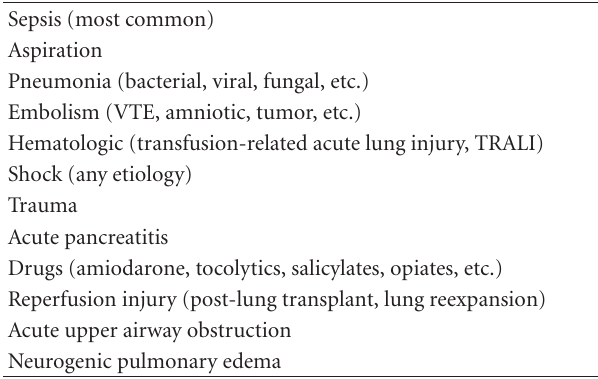
Table 3: Disorders associated with the acute respiratory distress syndrome